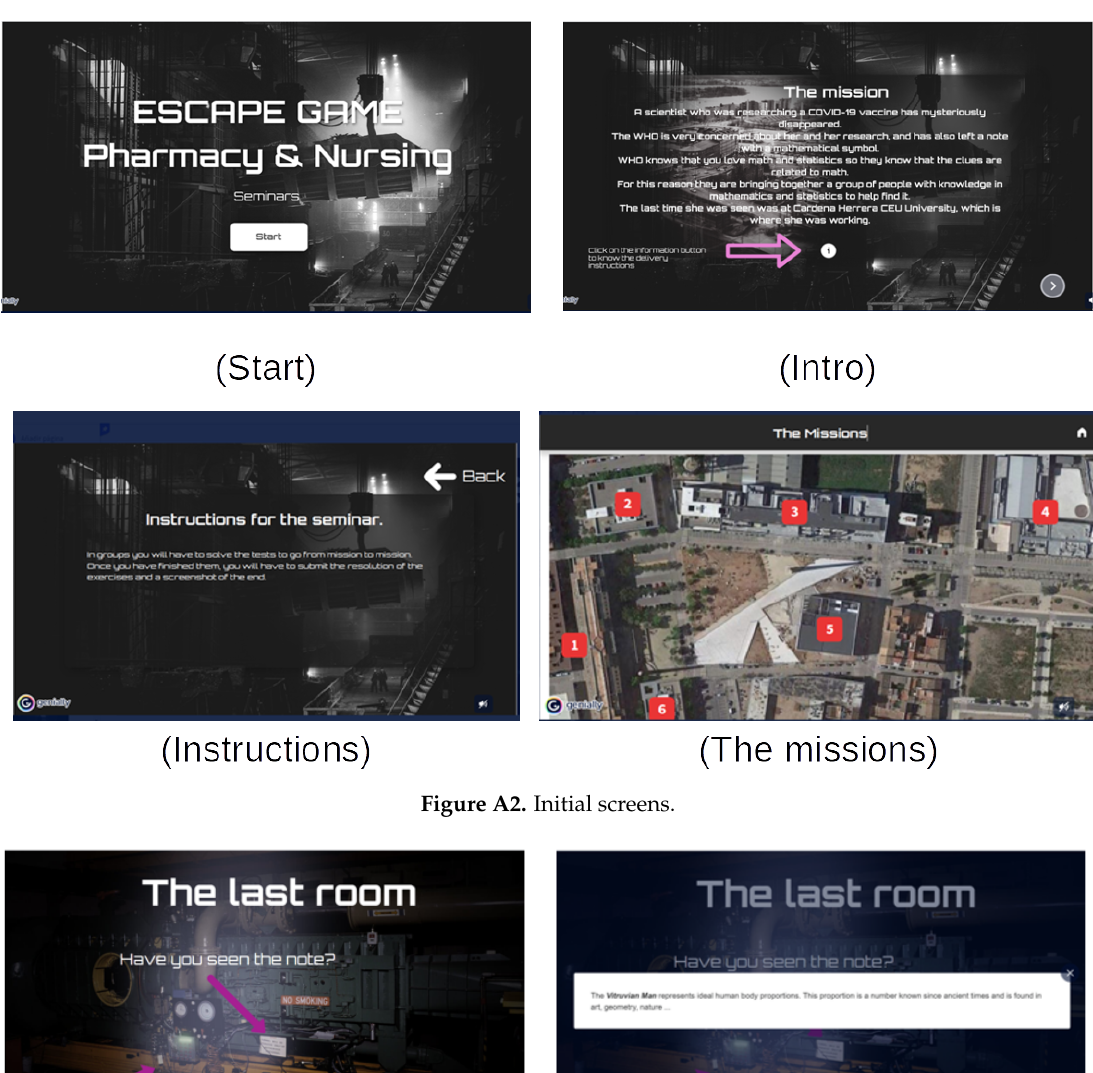
Figure A3. Hints in a